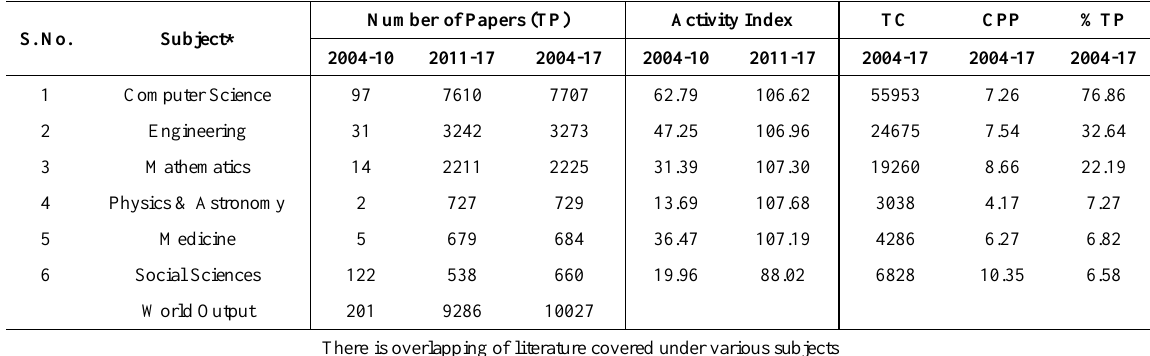
Table 3. Subject-wise break-up of global publications on deep learning during 2004-17 S.